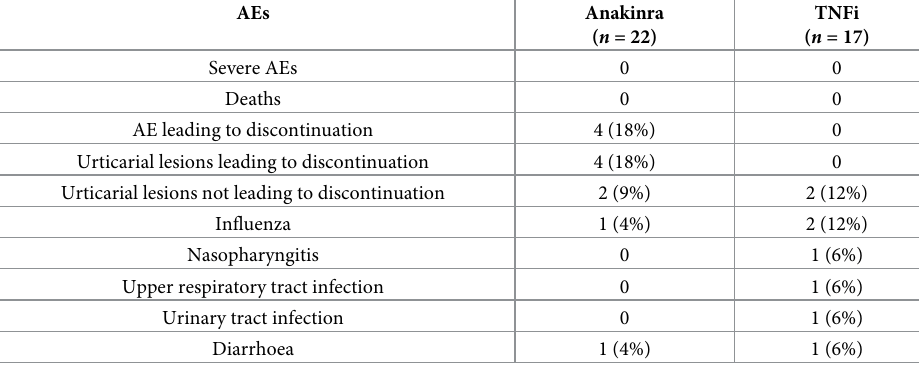
Table 5. Safety profile of the TRACK